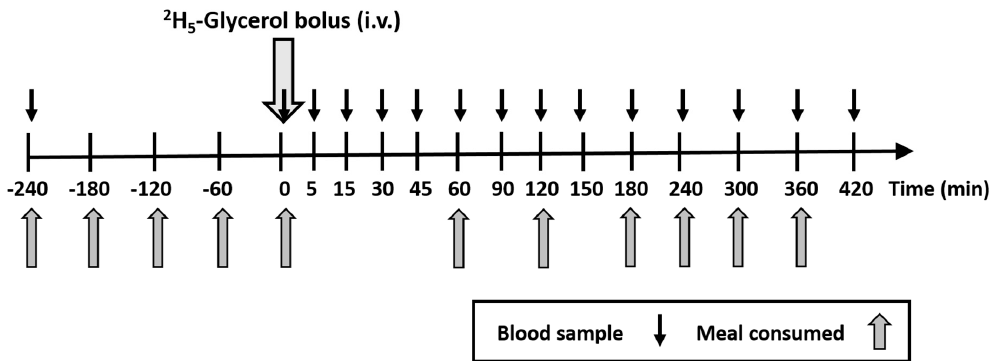
Figure 1. Summary of the protocol for metabolic study days.